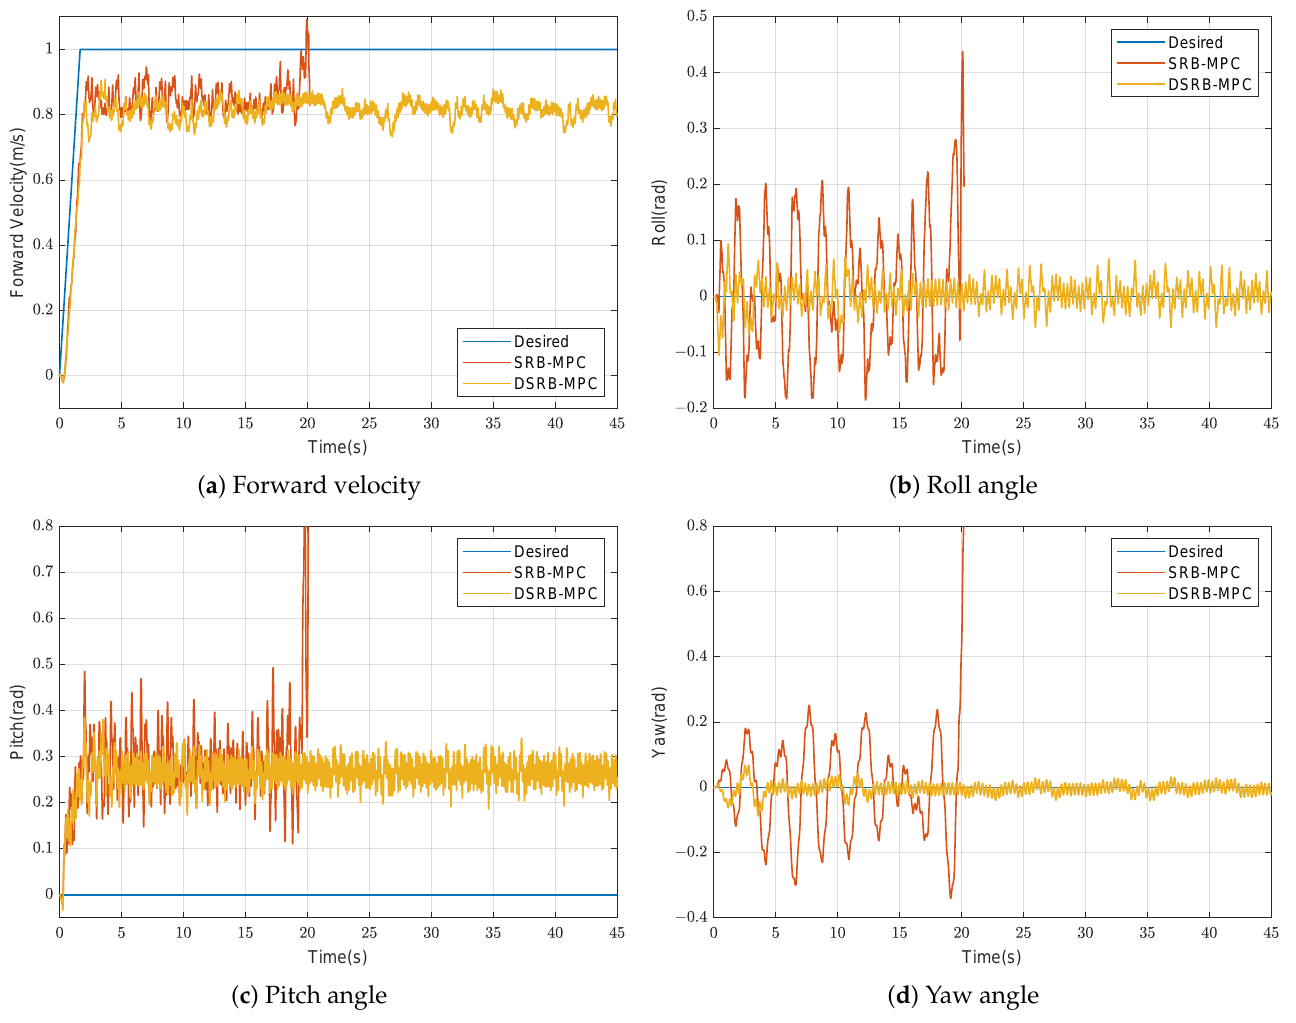
Figure 9. The performance of the DSRB-MPC under the extreme acceleration. ( a ) The command velocity and measured actual velocities of are presented. ( b ) The command roll angle and measured actual roll angles are presented. ( c ) The command pitch angle and measured actual pitch angles are presented. ( d ) The command yaw angle and measured actual yaw angles are presented. Note that all blue lines represent given reference signals. Red lines show the performance of SRB-MPC. Yellow lines show the performance of DSRB-MPC. The red line stops because the error of SRB-MPC exceeds the maximum error, the simulation stops at about 20 s. The reason for being unstable of SRB-MPC is that the disturbances of the swinging leg are not considered in the modeling, and the modeling error is too large. In this situation, modeling error for Θ is too large, and MPC cannot resist. However, DSRB-MPC can accurately model disturbances and resist